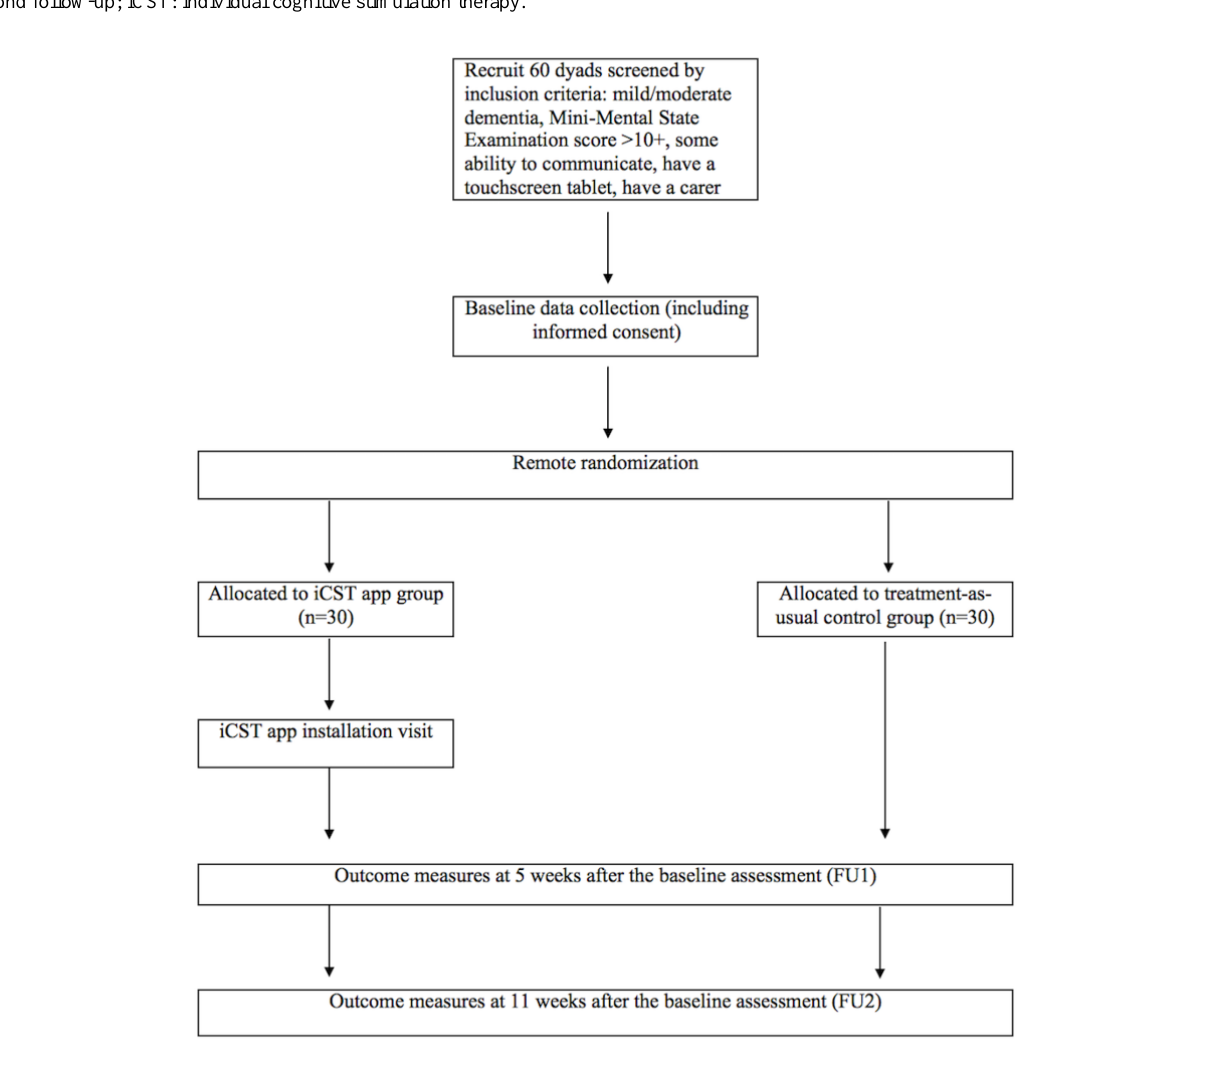
Figure 1. Flow diagram for the feasibility randomized controlled trial of the individual cognitive stimulation therapy app. FU1: first follow-up; FU2: second follow-up; iCST: individual cognitive stimulation